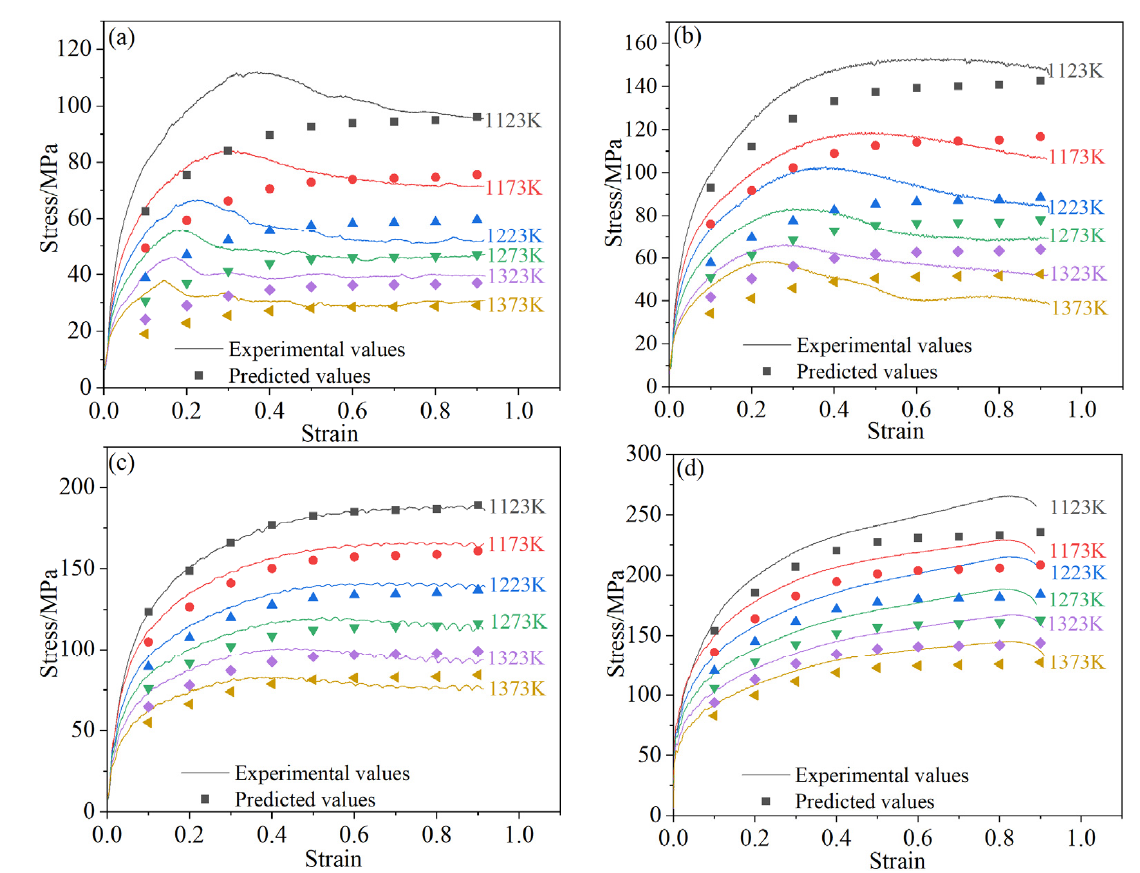
Figure 6. Comparison between predicted and experimental flow stress using Modified Johnson–Cook model at different strain rates: ( a ) 0.01 s − 1 ; ( b ) 0.1 s − 1 ; ( c ) 1 s − 1 ; ( d ) 10 s − 1 .